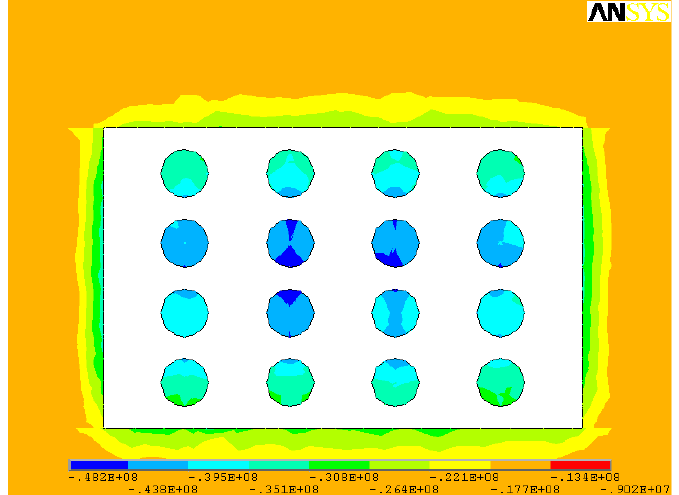
Figure 30. Minimum principal stress distribution in the middle of the pillar at 1480 mL of scheme 6 (parameters of scheme 6: stope height 3.5 m, pillar diameter 4 m, pillar spacing 6 m, pillar row spacing 9 m).